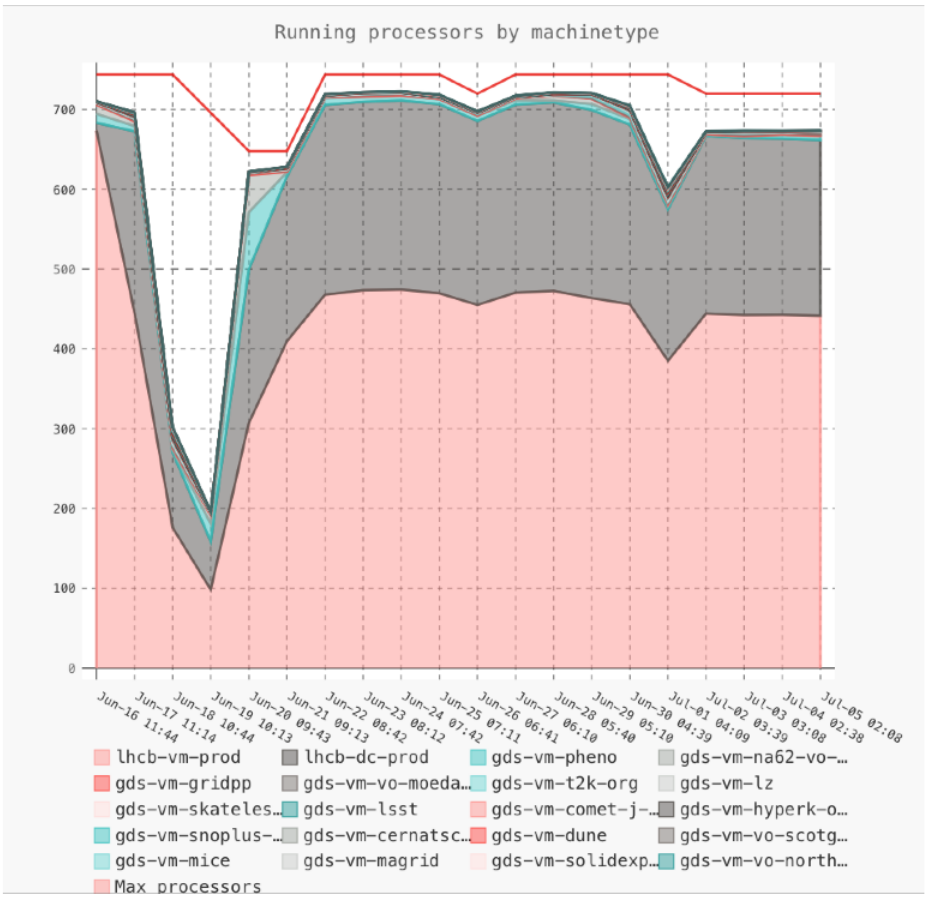
Fig. 2. VMs and Docker containers during a production test in June/July 2017. The trough in mid June was due to an unrelated software